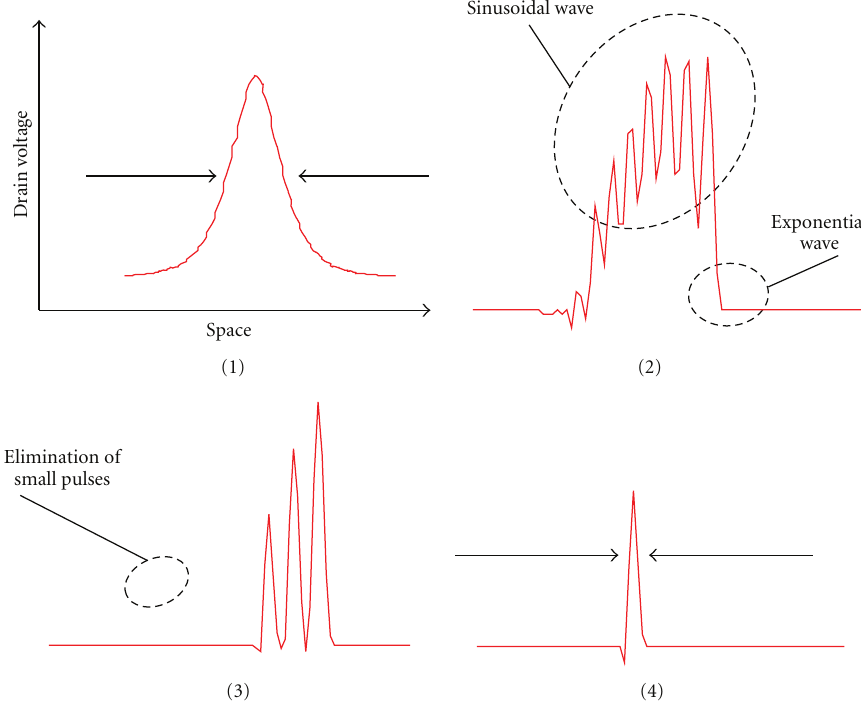
Figure 3: Operation principle of pulse shortening in